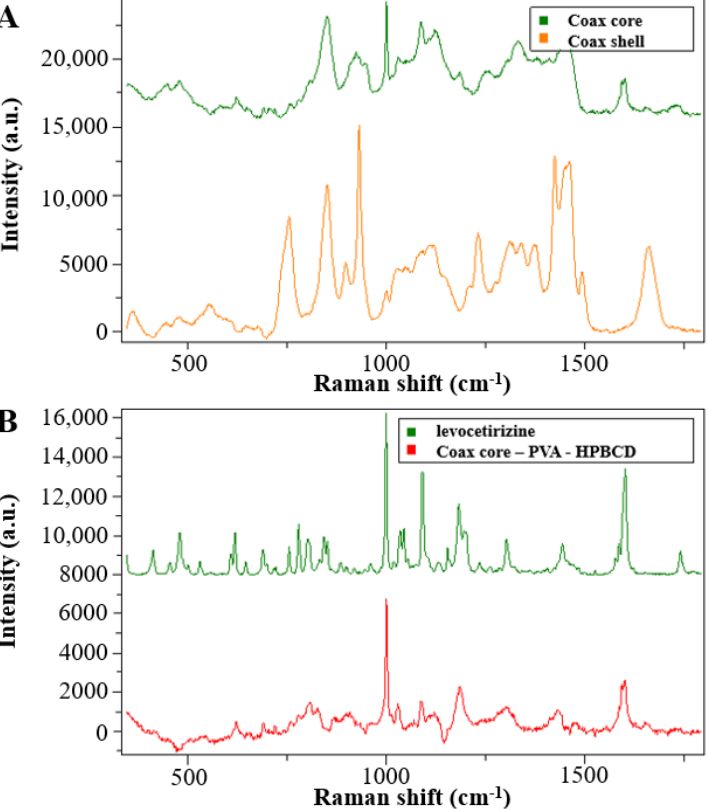
Figure 5. Raman spectra of the coaxially electrospun samples ( A ) and the crystalline levocetirizine and its embedded form ( B ).